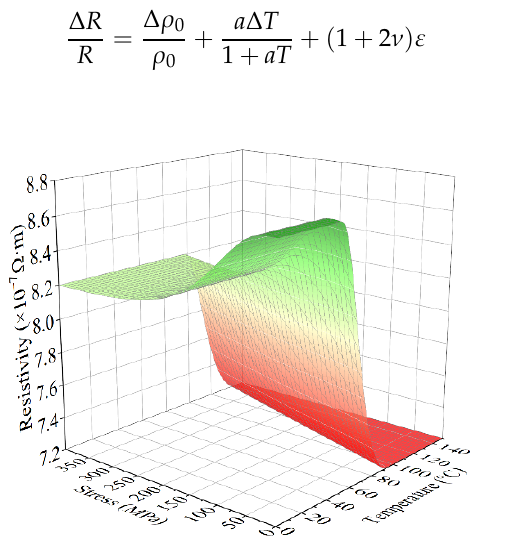
Figure 2. Relationship between temperature, stress and resistivity of the SMA.